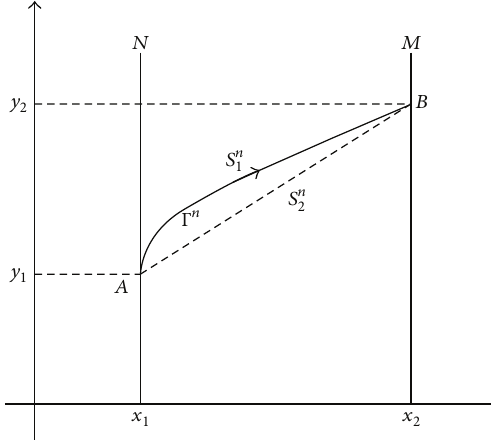
Figure 9: Γ is the order-1 periodic solution of system (1). Figure 10: Γ